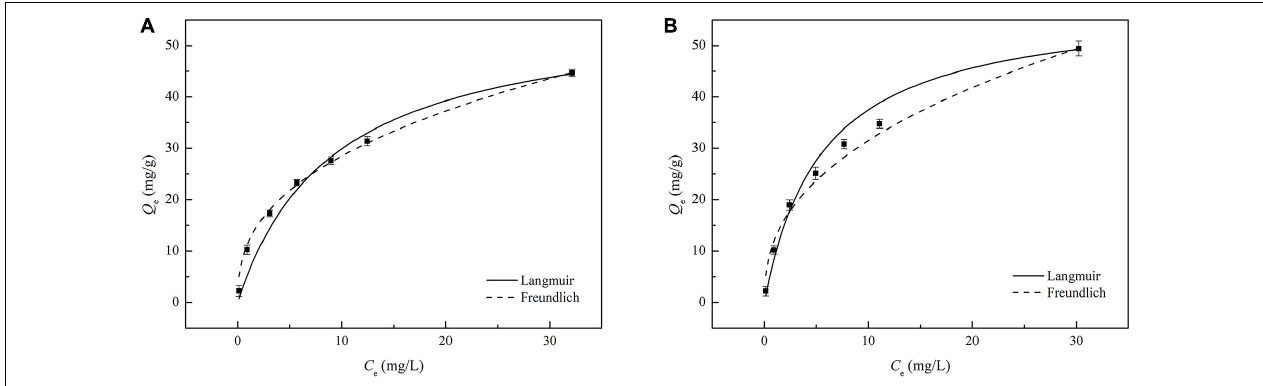
FIGURE 6 | The adsorption isotherm data of TC adsorption on PBC (A) and TPBC (B) investigated using a non-linear method. TABLE 4 | The calculated parameters of different adsorption isotherms using linear regression at 25 ◦ C. Samples Langmuir Freundlich